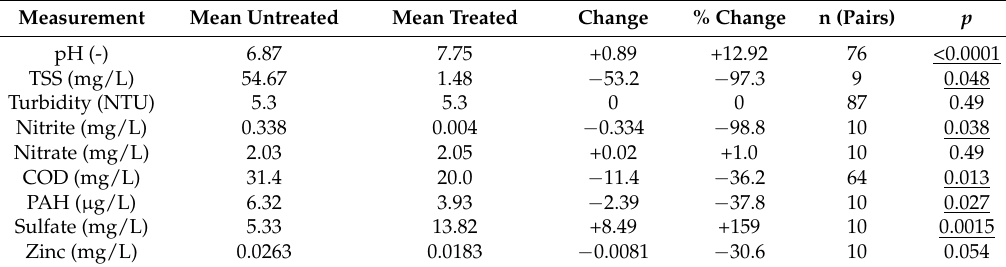
Table 2. Summary of measurements and statistical analysis. Underlined p -values are